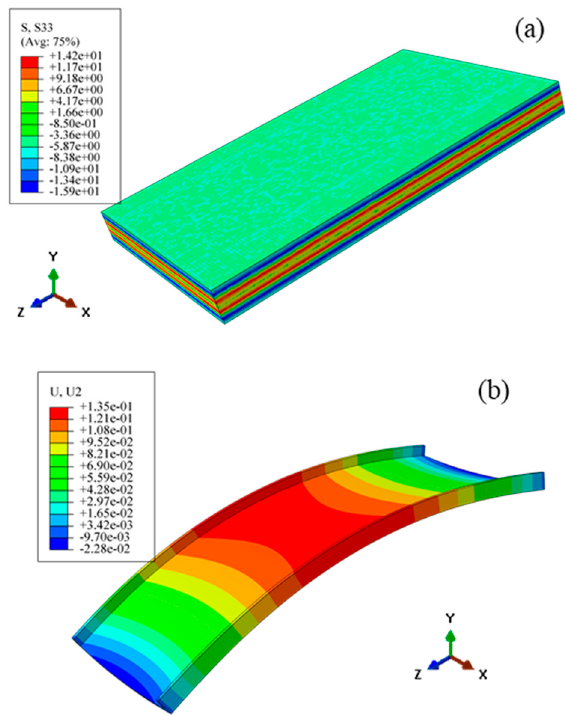
Figure 6. Initial residual stress inside the blank of blank 1. ( a ) The FE model of Blank 3 (unit = MPa). ( b ) The simulation results (part 2, blank 3, A2 = 7 mm, unit = mm).